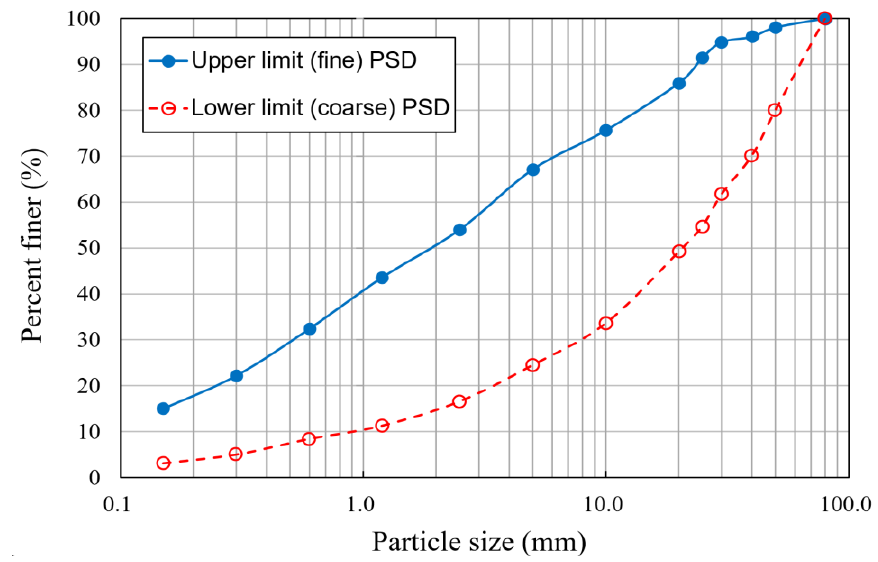
Figure 1. Particle size distribution of aggregate.